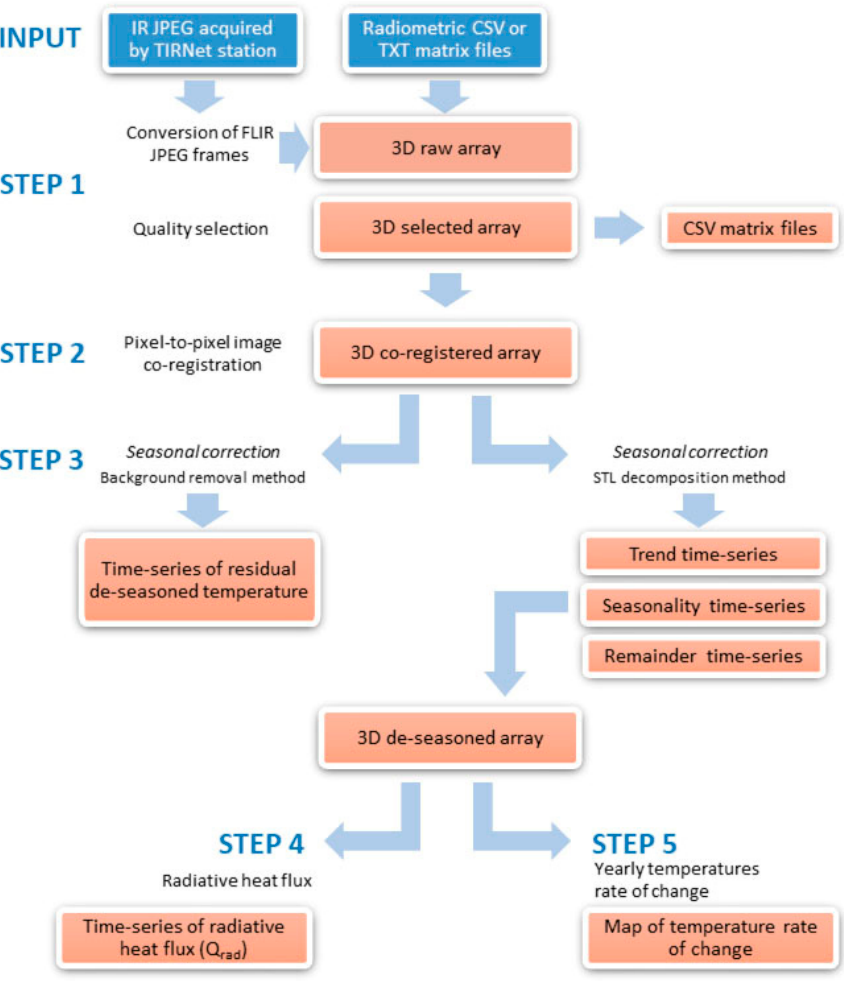
Figure 2. Block diagram of IR images processing steps. 3D: three-dimensional. 127